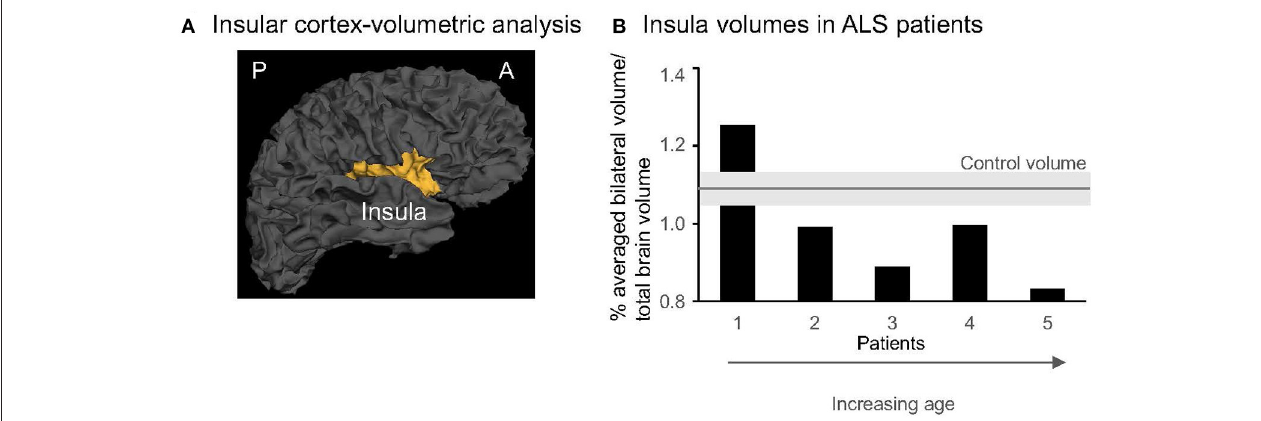
FIGURE 3 | (A) 3-D gray matter insula in one control (Freesurfer, sagittal view). A, anterior; P, posterior. (B) Individual insular volumes were expressed as % of the total brain volume in patients (black columns) and controls (gray line indicates the mean, light gray rectangle indicates the SD for the group). The patients were presented from the youngest (1) to the oldest (5). Note that the last 3 patients (#3–5) are aged > 50 years and represent the older